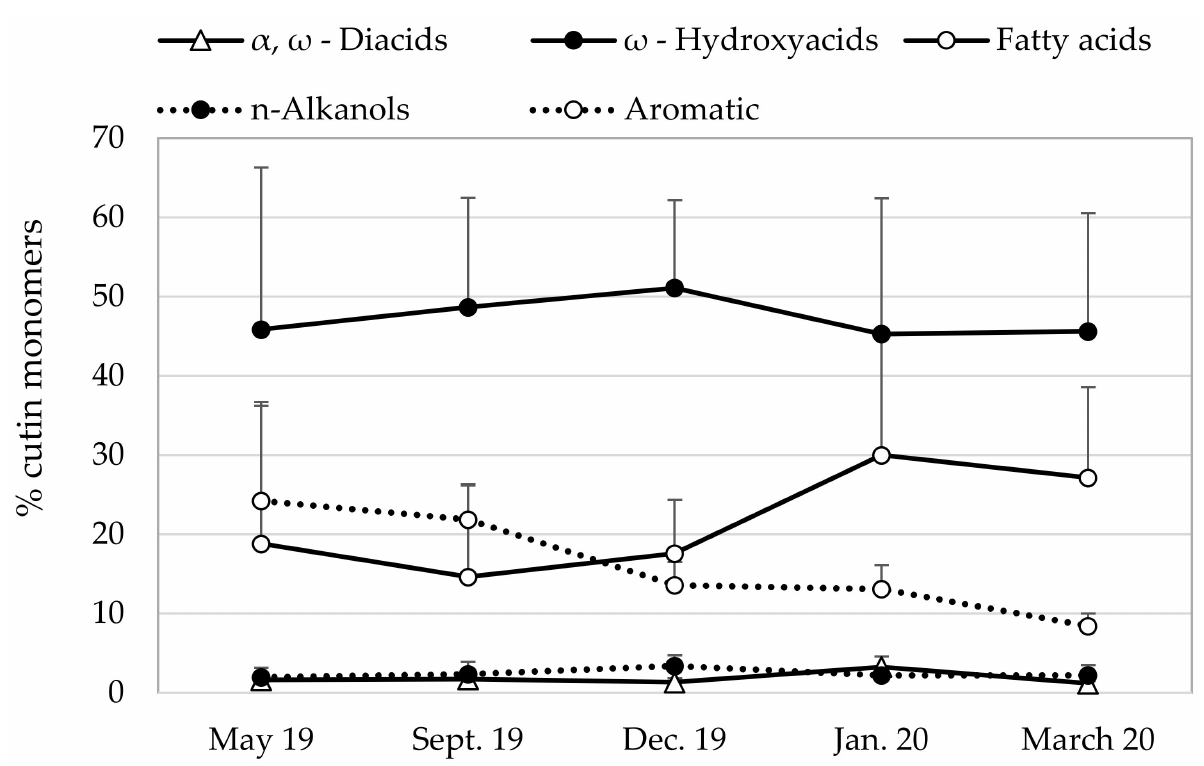
Figure 3. Seasonal variation in the cutin chemical families of Quercus suber leaves, in % of the total monomers released by transesterification of the extracted leaves (mean of six provenances with two trees per provenance and half standard deviation as